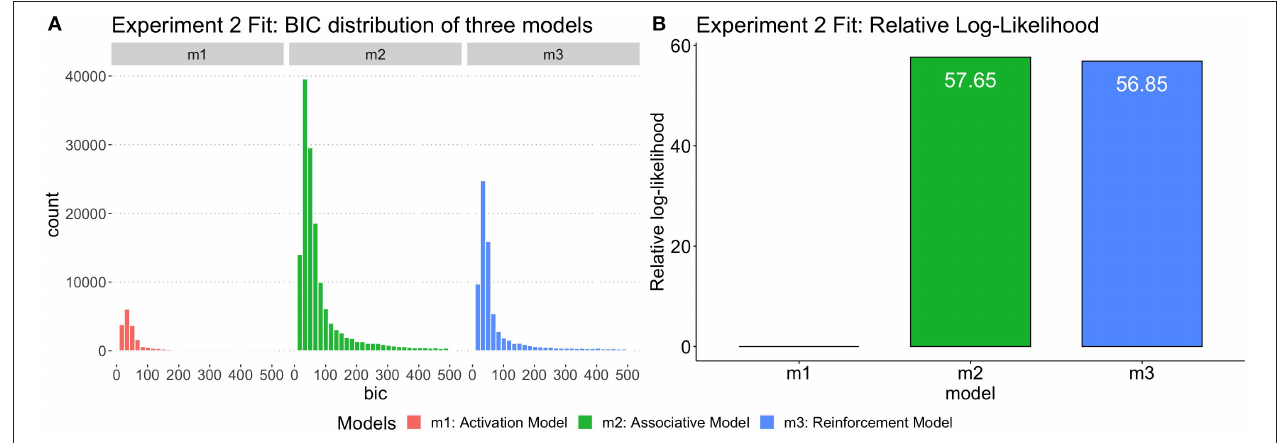
FIGURE 6 | (A) The distribution of BIC for three models fit by Experiment 2 data. (B) The relative log-likelihood of three models fit by Experiment 2 data. The relative-likelihood is the ratio of the group-level likelihood to the minimum log-likelihood of three models. Consistent with statistical analysis, 17 subjects were excluded from simulation data